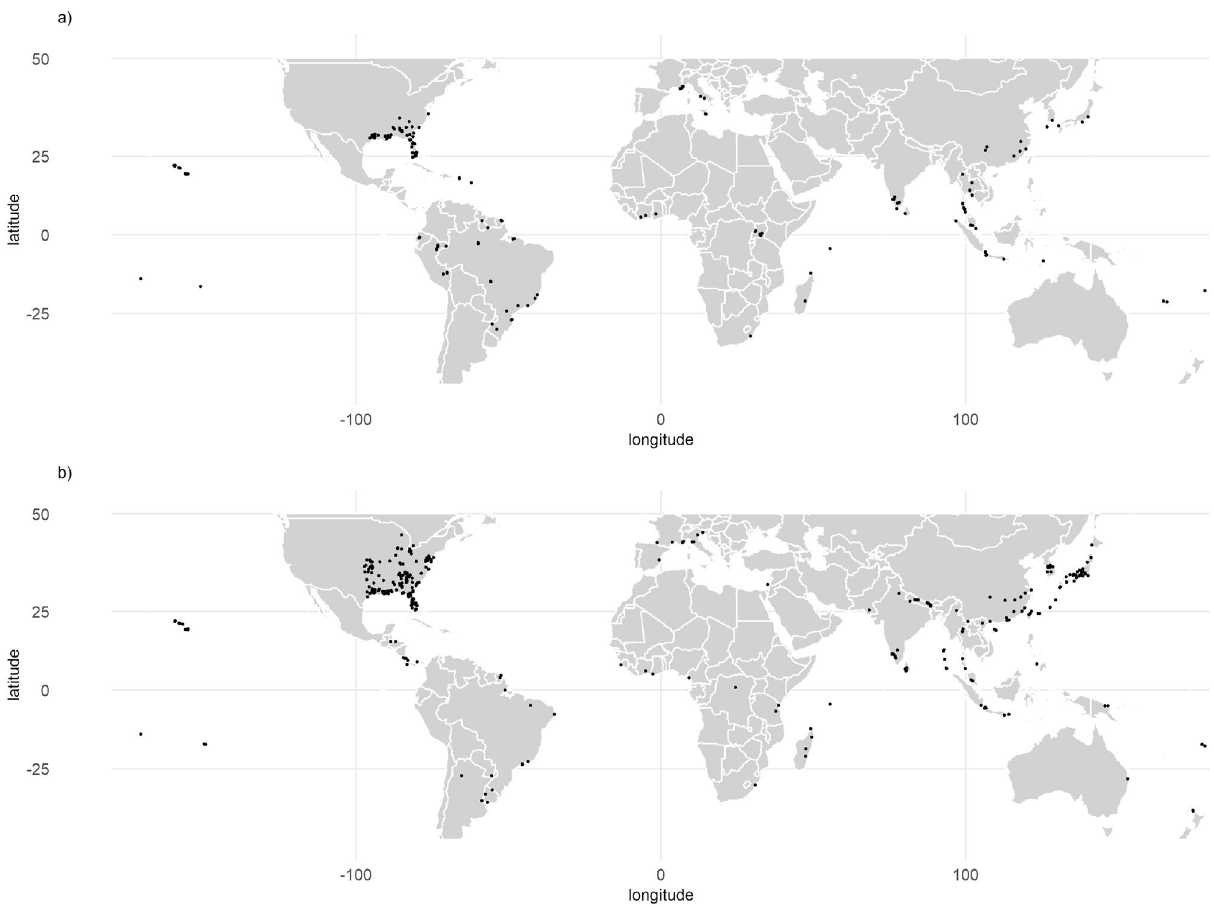
Figure 1. Occurrence data used in the present study of ( a ) Xylosandrus compactus (n = 205) and ( b ) Xylosandrus crassiusculus (n = 311) after duplicate removal. The maps were generated using R 4.0.0 (https ://cran.r-proje